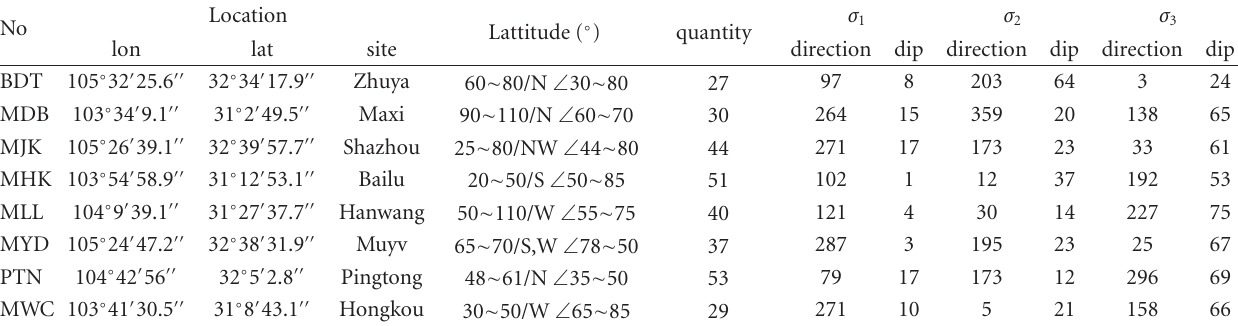
Table 1: The inverted result of tectonic stress tensor of each measuring